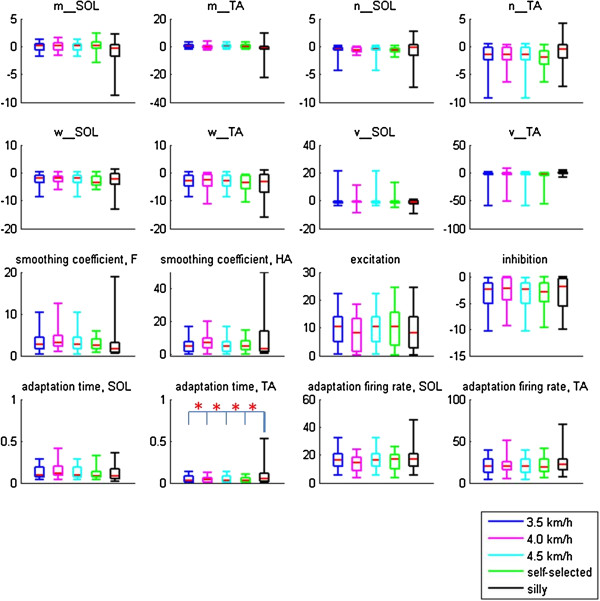
Values of all parameters at different speeds and silly walks. The tops and bottoms of the boxes are the 25th and 75th percentiles of the parameters respectively. Red lines indicate the median values. Parameters m and n are weights related to the normalised force F, while parameters w and v are weights related to hip angles HA (refer to equations 4–6). SOL: soleus, TA: tibialis anterior. (*) denotes significant difference.